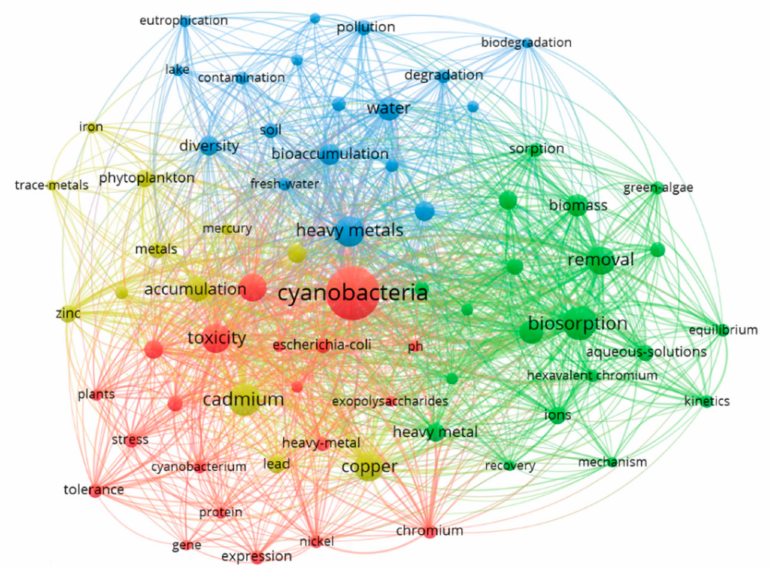
Figure 2. Network visualization of terms associated with